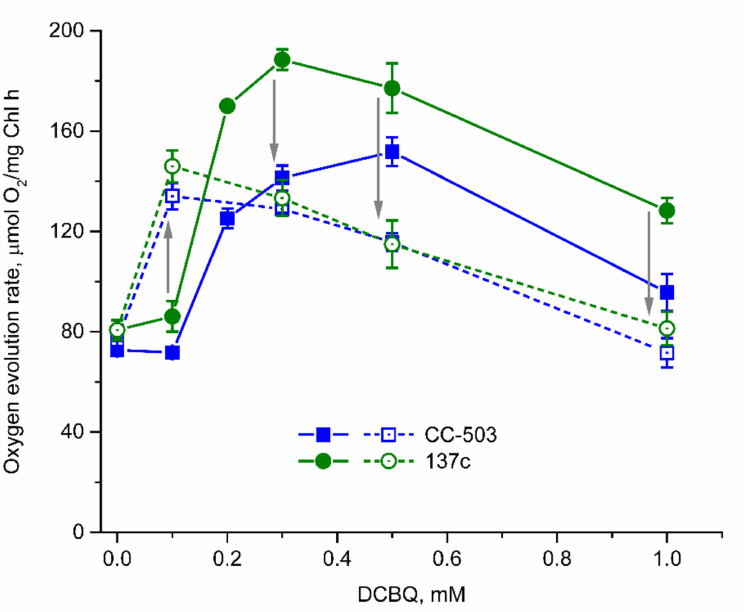
Figure 4. Dependence of the O 2 evolution rate on DCBQ concentration in the absence of FeCy (solid lines) and after the addition of 0.5 mM FeCy to the same sample with repeated measurement of O 2 evolution (dashed lines) in living cells of CC-503 (blue squares) and 137c (green circles) strains of C. reinhardtii . Arrows indicate the direction of changes that occurred after FeCy addition in repeated measurements of O 2 evolution. SDs ( n = 5) are shown as